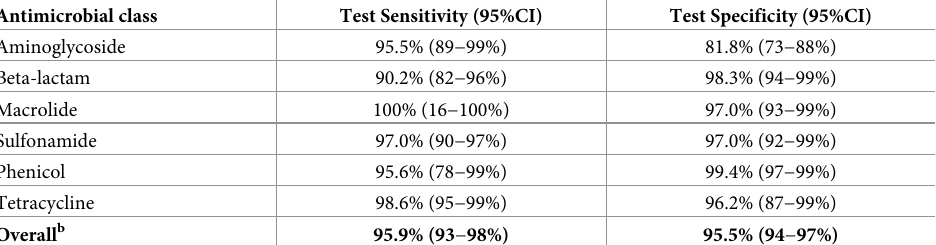
a Phenotypic antimicrobial resistance test results were considered the gold standard. Detection of 15 antimicrobials performed using the CMV3AGNF panel from National Antimicrobial Resistance Monitoring System (Sensititre, Thermo Scientific). In silico acquired resistance genes detected using Abricate and the Resfinder database. b Raw counts for all isolates and antimicrobials were pooled